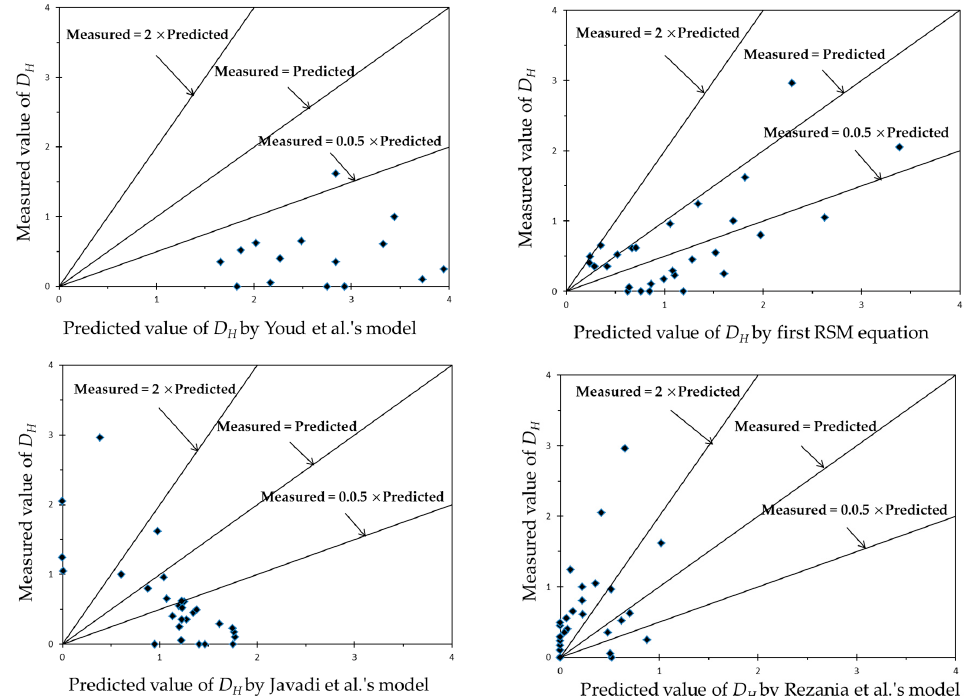
Figure 6. Comparison between the first RSM equation and three extra models with 28 data points measured from sites of Chi-Chi earthquake.